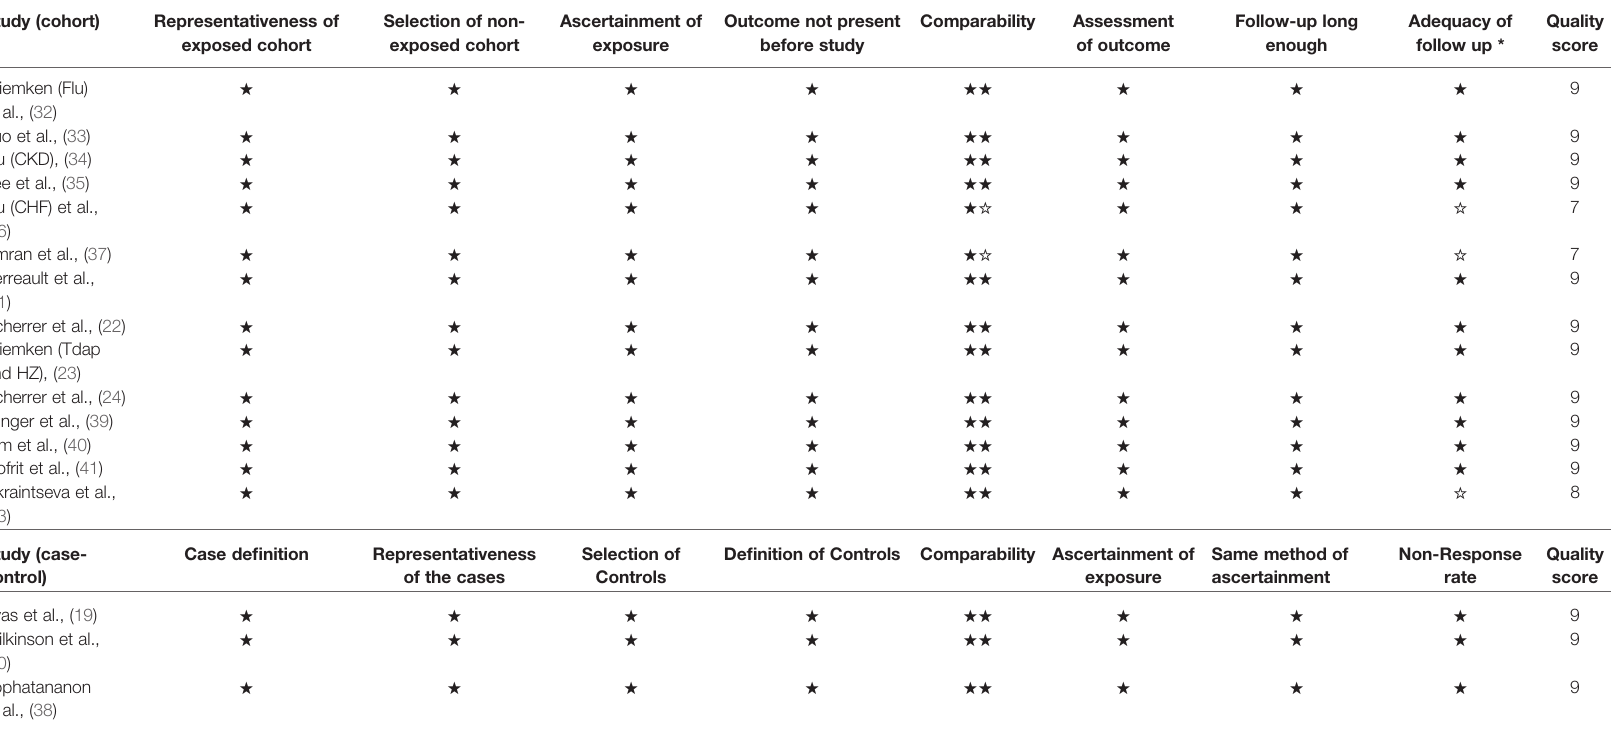
TABLE 2 | The quality assessment of included